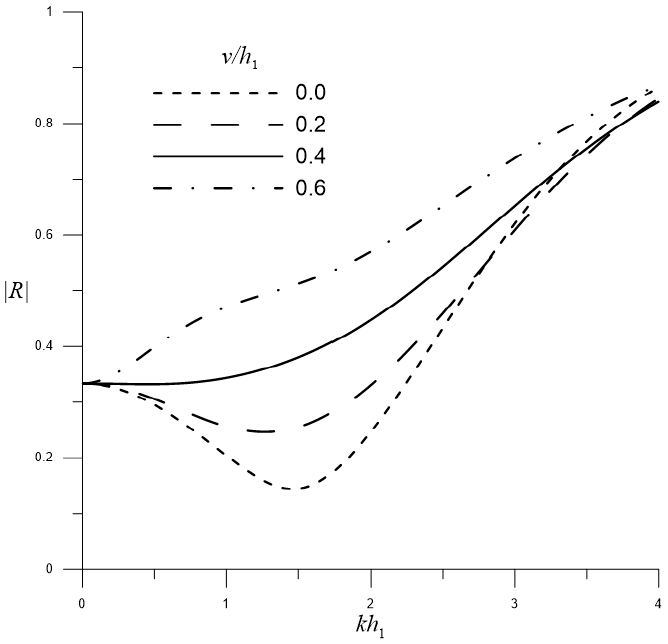
Figure 9. Reflection coefficient | R | varying against kh 1 for a single surface-piercing barrier at different locations.